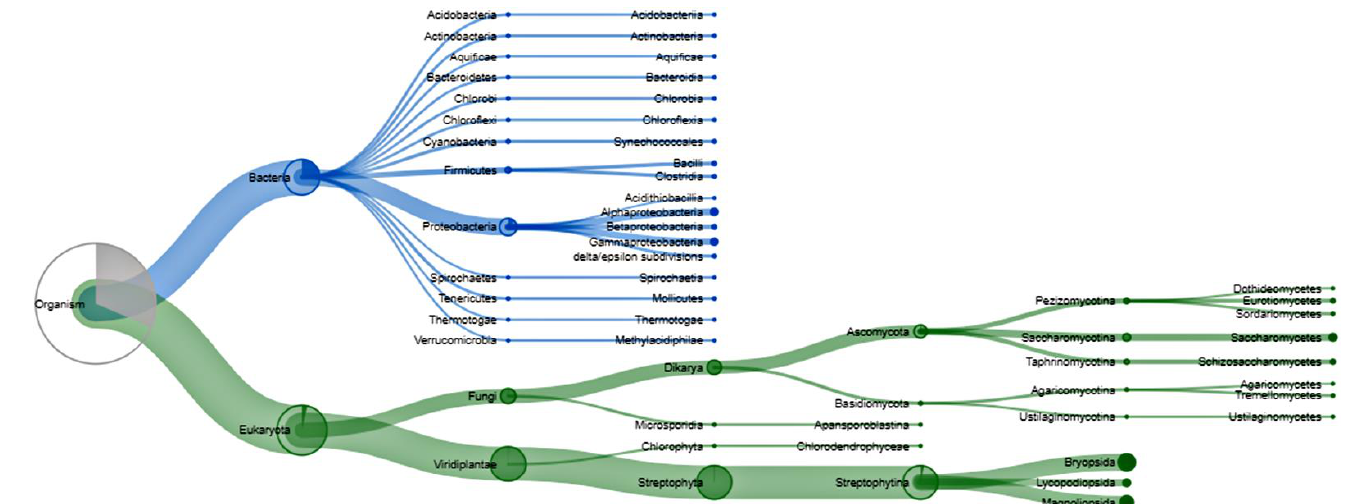
Figure 3. Peptide-based dendrogram constructed by Unipept 4.0 using all peptides with protein matches in this study. The phylogenetic tree was constructed using the lowest common ancestor (LCA) method. The circles’ sizes refer to the peptide abundance for each taxonomic level.